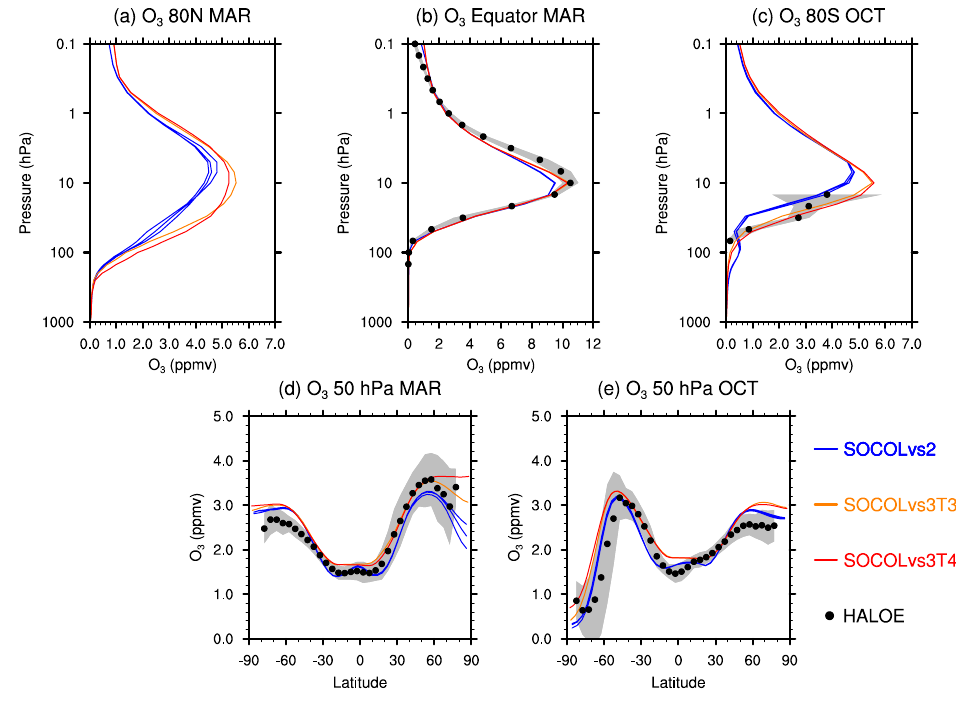
Fig. 10. Same as in Fig. 6 but for ozone in